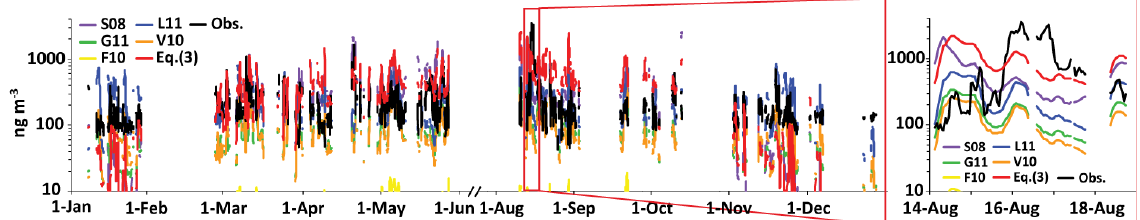
Fig. 4. Comparison of hourly submicron OM concentrations from Mace Head for 2009 during clean marine conditions as measured by an Aerosol Mass Spectrometer (AMS) with hourly modeled marine POA concentrations. The inset shows the comparison for the marine organic aerosol plume event described by Ovadnevaite et al. (2011a). White areas indicate missing data. Table 3. Comparison of GEOS-Chem marine POA surface concentrations with monthly and weekly average submicron WIOM concentration observations from Mace Head and Amsterdam Island.